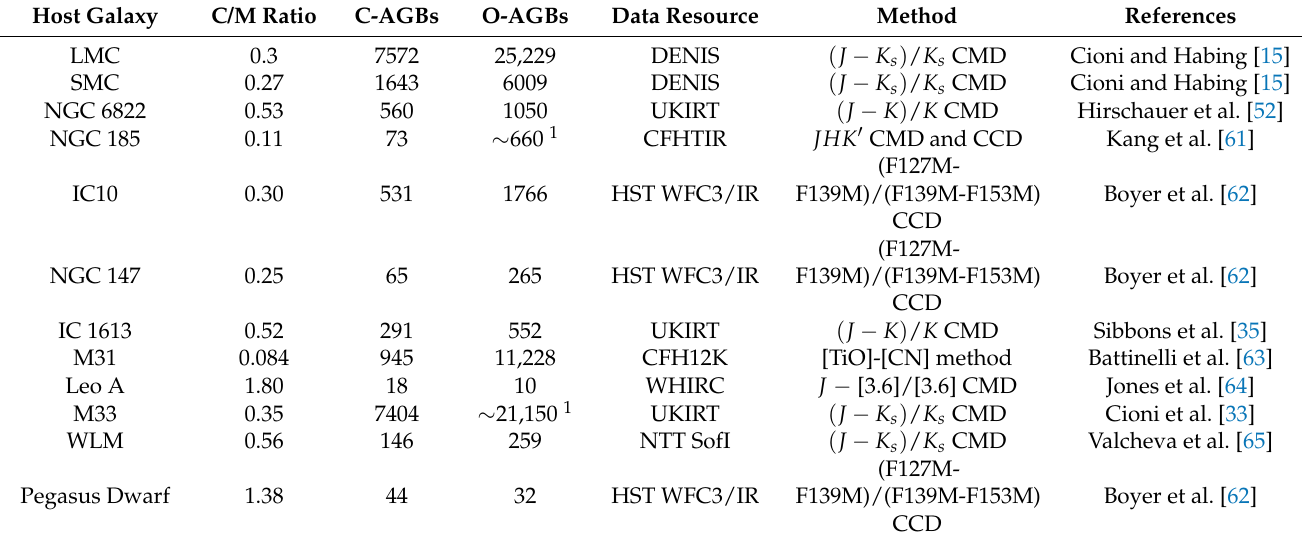
Table 4. The C/M ratio in previous